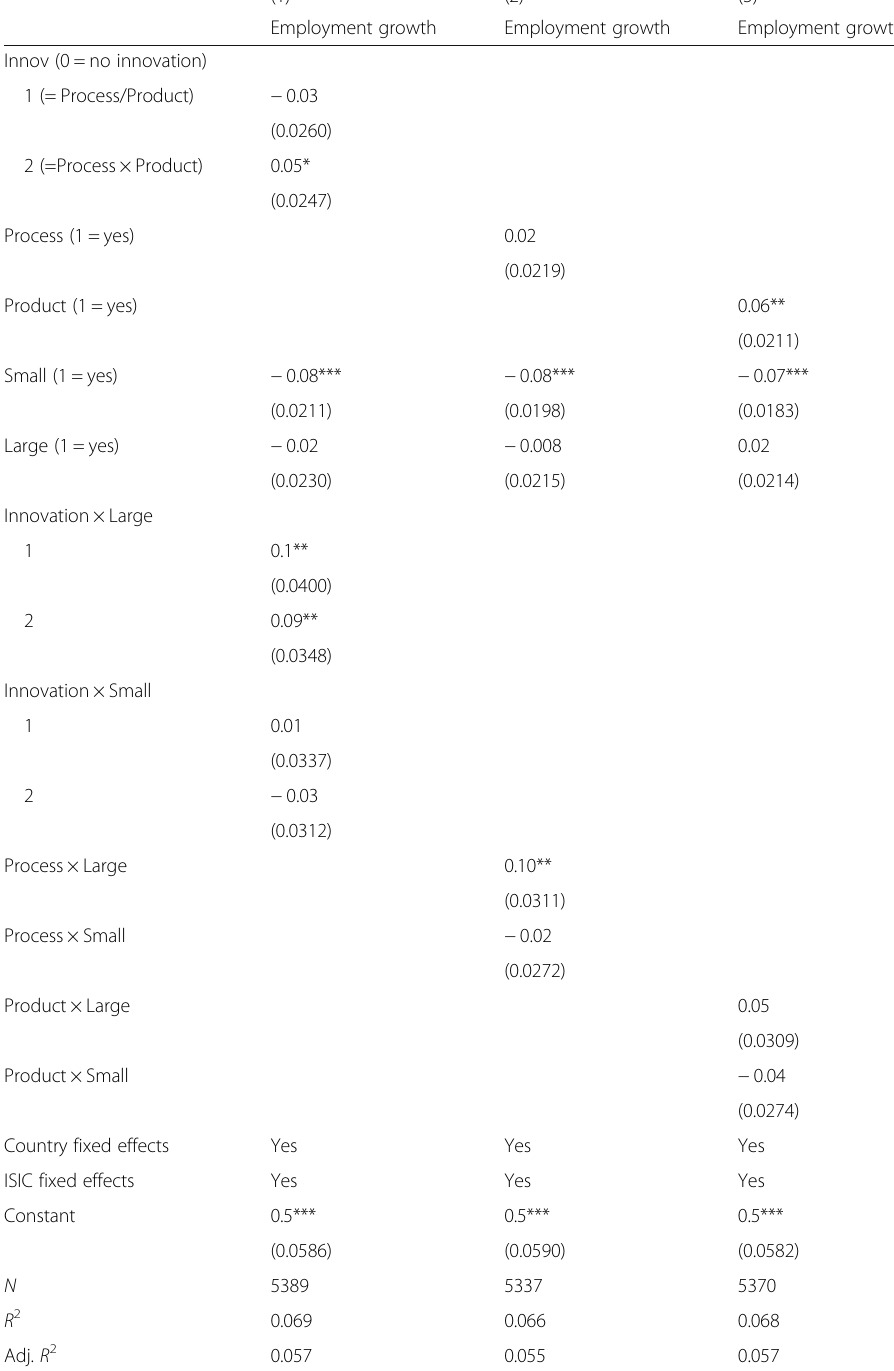
Table 6 Interaction between innovation and firm size Employment growth Employment